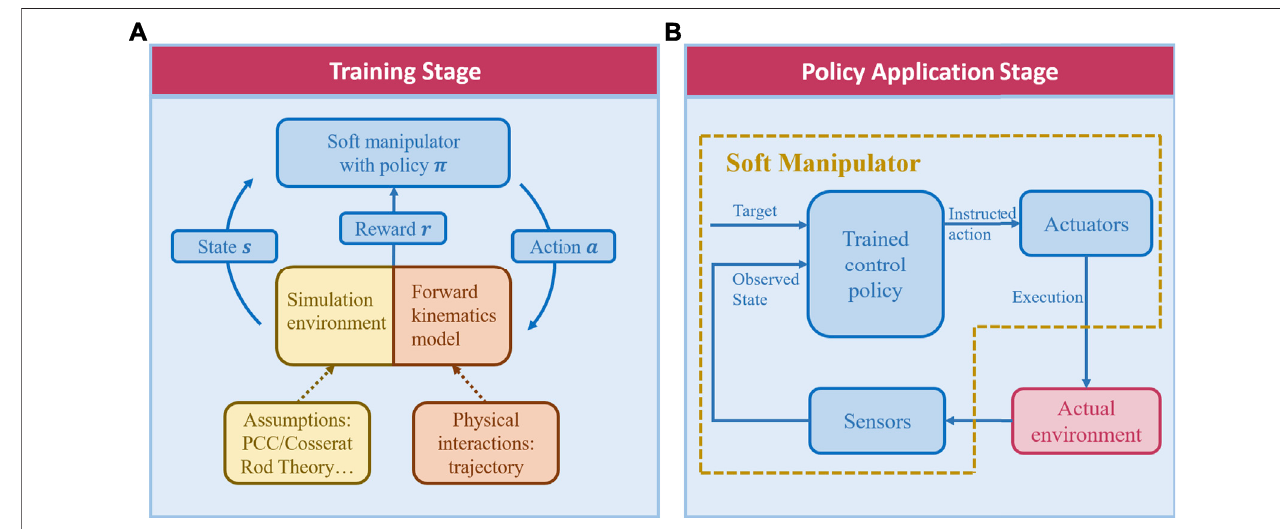
FIGURE 3 | Schematics of reinforcement learning in soft robot manipulation, with (A) the policy training stage and (B) the application stage separately shown.